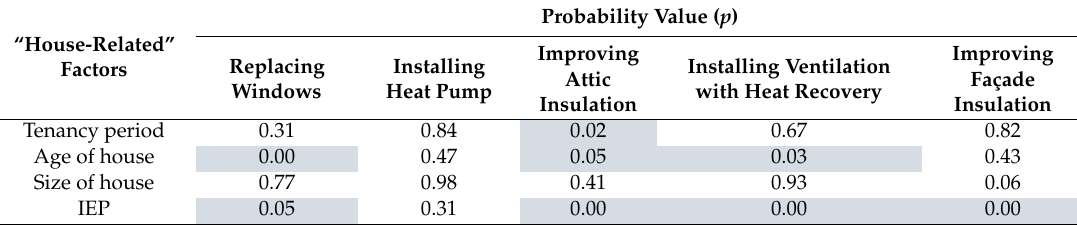
Table 3. Influence of “house-related” factors on homeowners’ interest to adopt EEMs.